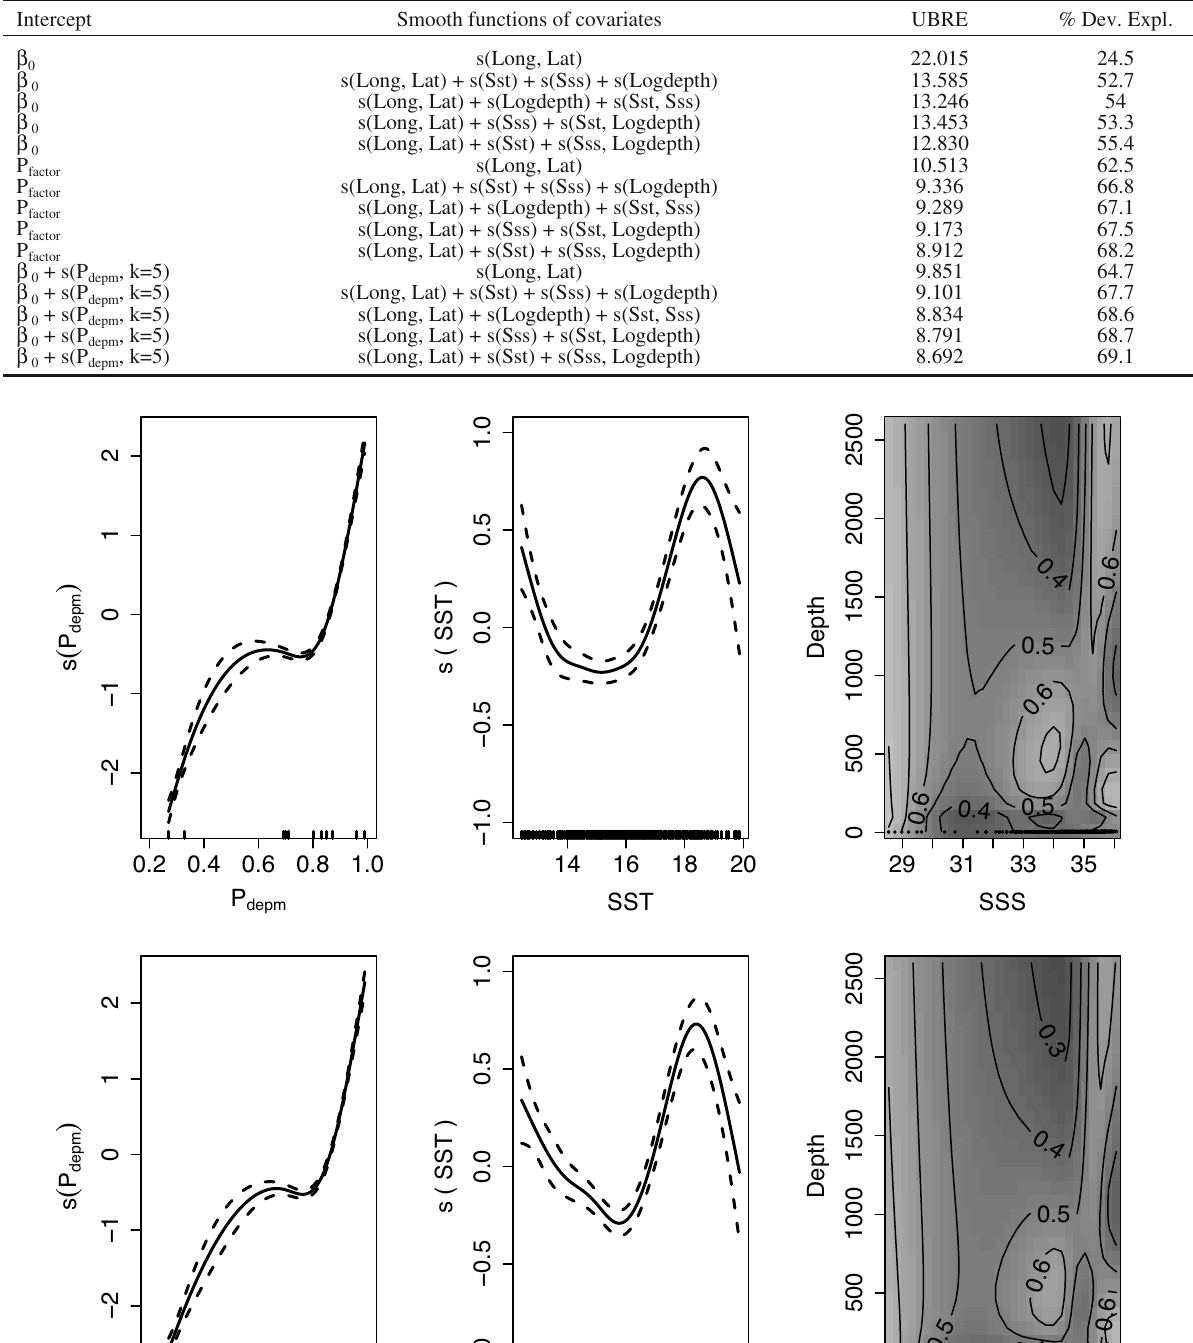
Table 2. – Summary of the generalized additive models without allowing spatial changes that depend on P describe the model (the intercept and the smooth functions of the covariates). The last two columns give the un-biased risk estimator (UBRE) score and the % of deviance explained by each model.